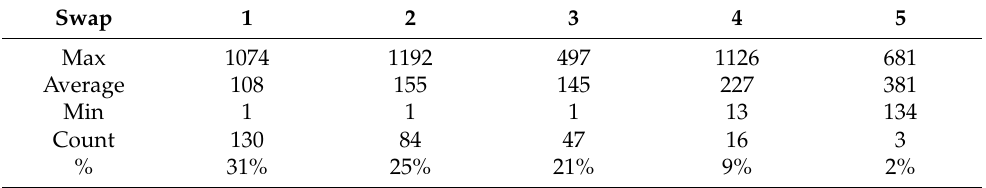
Table 3. Cost of the link swaps (meters) in MST-to-TSP during the algorithm with O-Mopsi data.